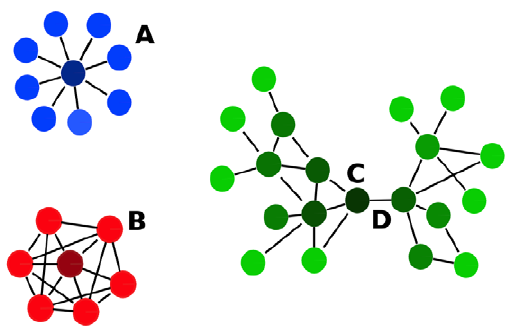
Figure 5. Local properties of the nodes represented by the different network parameters used. Connection degree was computed as the number of edges (interaction events) for a given node. A shows a node with a high connectivity. B has both high clustering coefficient and connectivity. C has a high betweenness. It is a hub because many shortest paths joining nodes pass through it. The connecting edge between two component ( D ) is known as the articulation